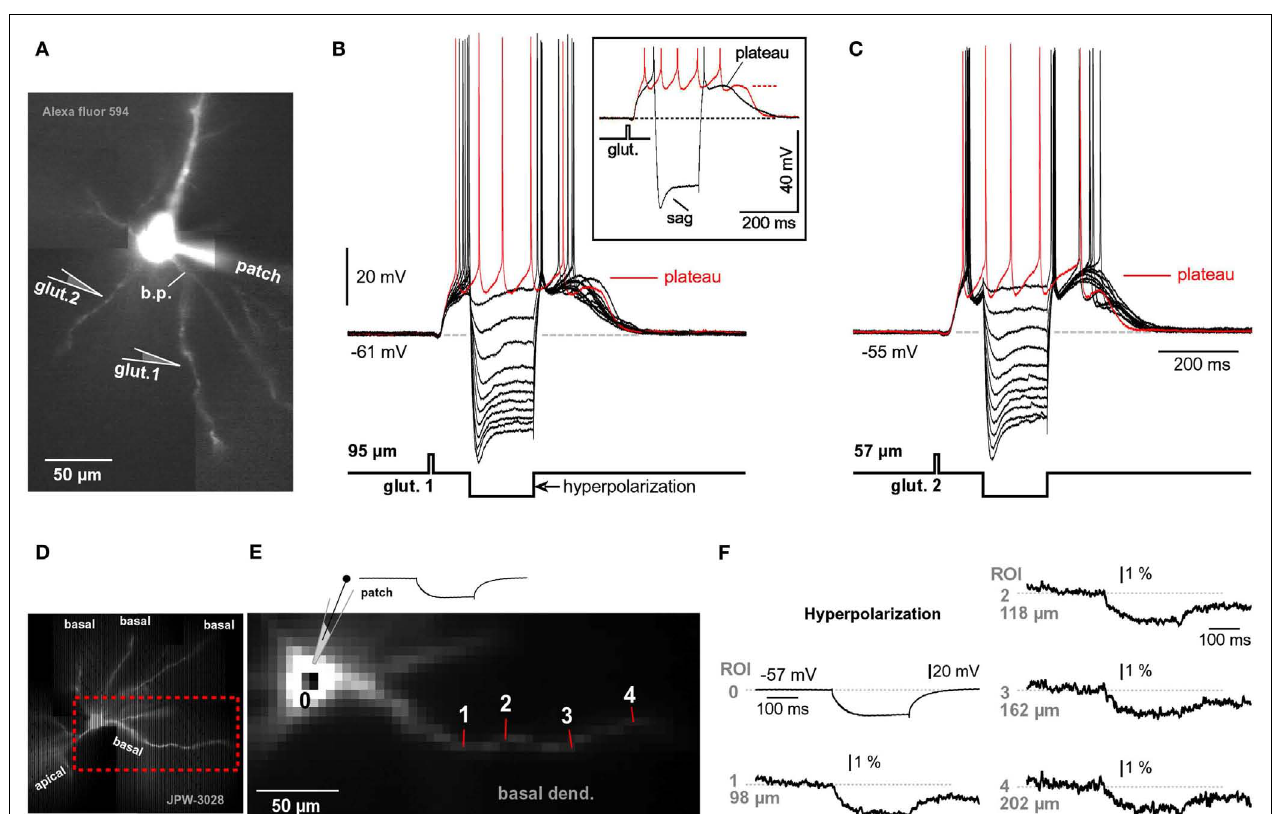
experimental paradigm as in (B) , except glutamate application micropipette was positioned closer to the cell body, at location marked by “ glut. 2 ,” 57 µ m from the soma. (D) Microphotograph of a pyramidal cell filled with voltage-sensitive dye JPW-3028. (E) Fast camera capture of the region marked by rectangle in (D) . Six to nine individual pixels were used for spatial averaging in each region of interest (ROI 1–4). (F) Patch clamp recording (ROI 0) is aligned with simultaneous voltage-sensitive dye recordings from four ROIs during somatic hyperpolarization ( − 36mV peak amplitude measured in the soma). Each optical trace is a temporal average of four